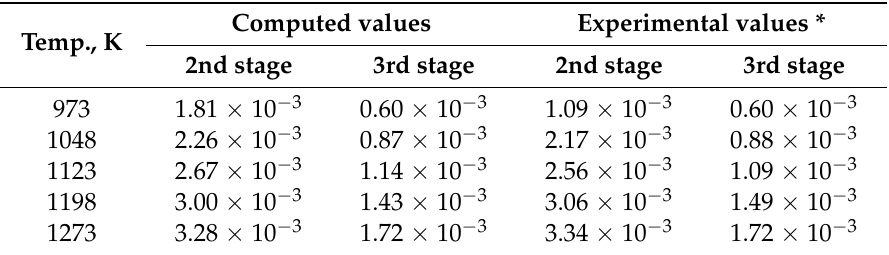
Table 2. Calculated and experimentally obtained reaction rate constants of NiWO 4 [3].